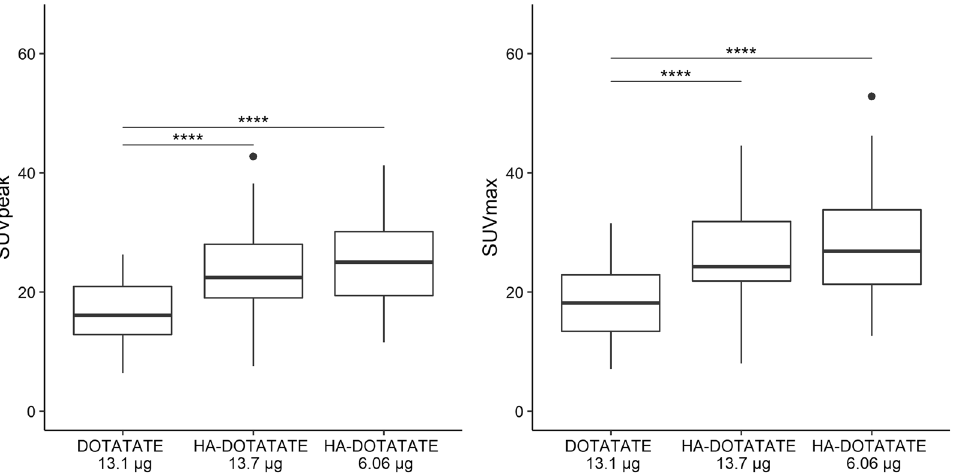
Fig. 3 Comparisons of spleen uptake after PET/CT in patients receiving [ 68 Ga]Ga‑DOTATATE or [ 68 Ga]Ga‑HA‑DOTATATE (low and high peptide amounts) showed a significant higher uptake for [ 68 Ga]Ga‑DOTATATE compared to [ 68 Ga]Ga‑HA‑DOTATATE. In addition, peptide amount differences for [ 68 Ga]Ga‑HA‑DOTATATE did not affect spleen SUV peak and SUV max . Lines indicate significant uptake differences between two groups (* p ** p 0.01, *** p 0.001 and **** p ≤ ≤ ≤